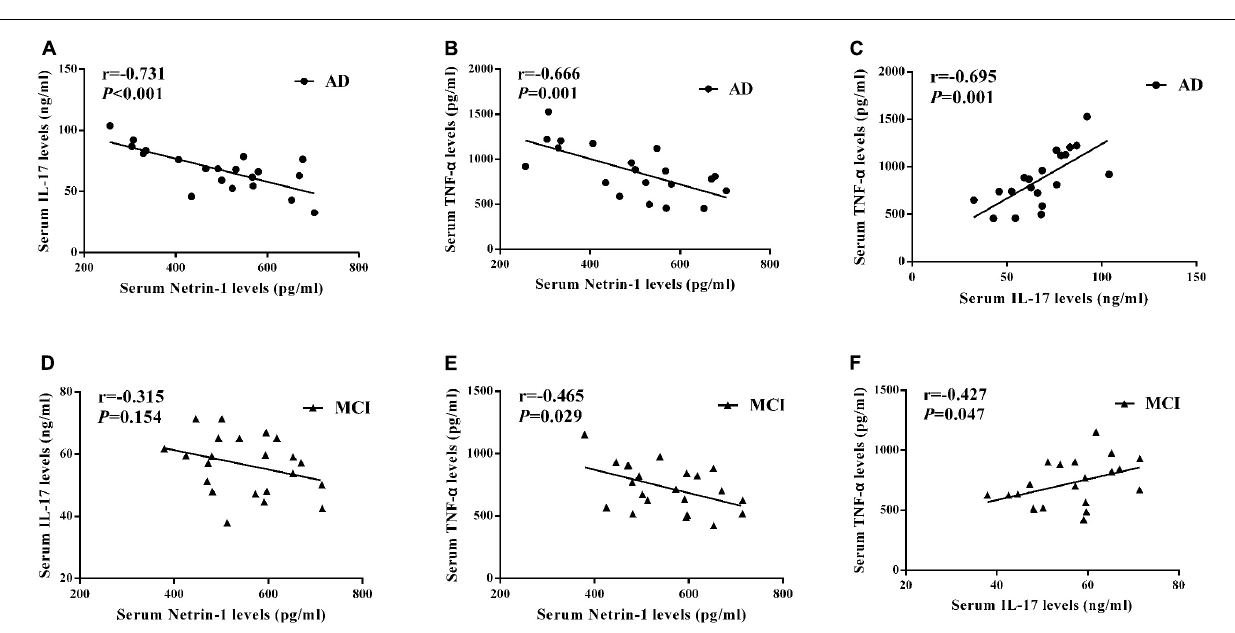
Levels of netrin-1, but not IL-17, were inversely correlated observed between serum netrin-1 and IL-17 in MCI cohorts,